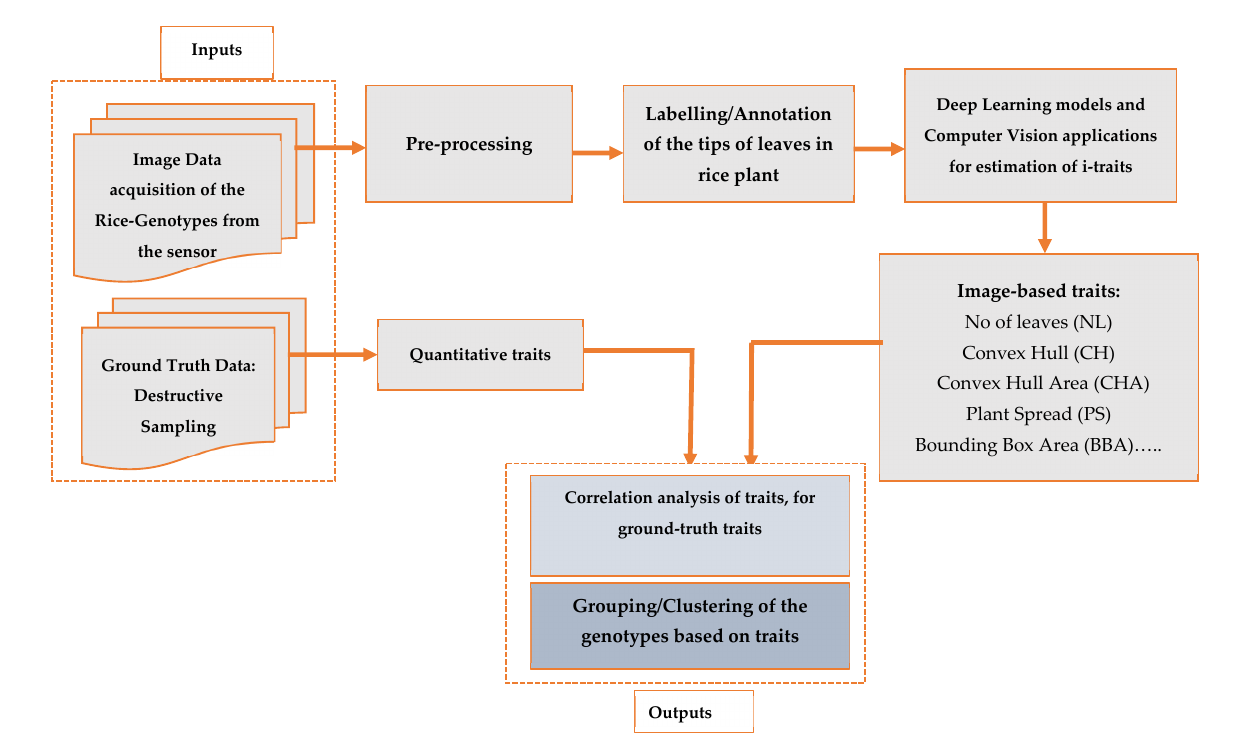
Figure 3. Schematic workflow of the framework for leaf counting, image ‐ based traits estimations, and grouping of the genotypes .